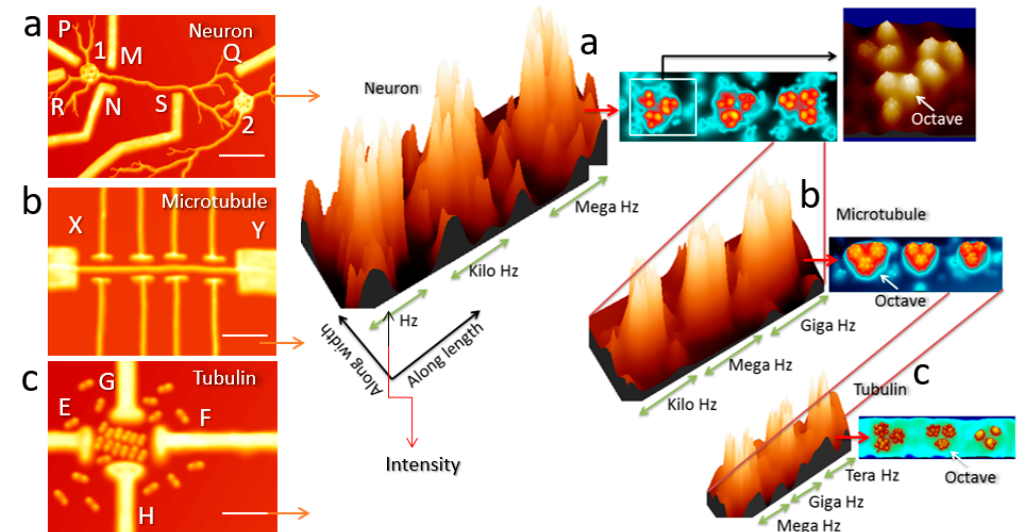
Figure 3. Self-similar resonance bands for neuron, microtubule and tubulin; ( a ) Microscope image Au electrode grid, rat hippocampal neuron, scale bar = 10 μ m. PQ and RS are non-contact electrodes to supply horizontal AC signal. MN electrodes are just across the AIS; ( b ) Atomic force microscopy (AFM) of a single microtubule, scale bar = 120 nm, XY are horizontal electrodes, the remaining four are transverse electrodes; ( c ) AFM of a tubulin substrate, scale bar = 50 nm. The three log–log scale plots of resonance frequency corresponding to the three experimental setups of panels a, b and c, are given to their right respectively. For panel A, the patch-clamp measured current difference between neuron 1 the soma and neuron 2 the soma is the vertical axis Imax = 10 nA, Imin = 1 pA (~80–2 mV). Two horizontal axes, one along the length (L = 50 Hz to 2.5 kHz, 2.5 to 250 kHz and 1 to 30 MHz) and the other along the width W. Wherein, W = L × 0.3, if L = 1 Hz, then, 0.3 Hz to 1.3 Hz variation was made along the vertical axis. Thus, the vertical axis is linear frequency width, its upper and lower limits are percentage values W min = − 30, W max = + 30 for all panels a, b and c. For panel b and c, the 3D resonance plot’s vertical axis is relative AC power transmission (P output / P input = P (0 < P < 1)) across the horizontal XY and EF electrode pairs respectively. Horizontal axes are frequencies for all three panels. For panel (a) the length, width vertical ranges are noted above, for panel b ranges are (triplet band) 10–300 kHz, 10–230 MHz and 1–20 GHz; for panel c ranges are (triplet band) 30–450 MHz, 1–250 GHz and 20–350 THz. To the right of all three 3D plots we show the corresponding vertical visuals, panel a is zoomed.